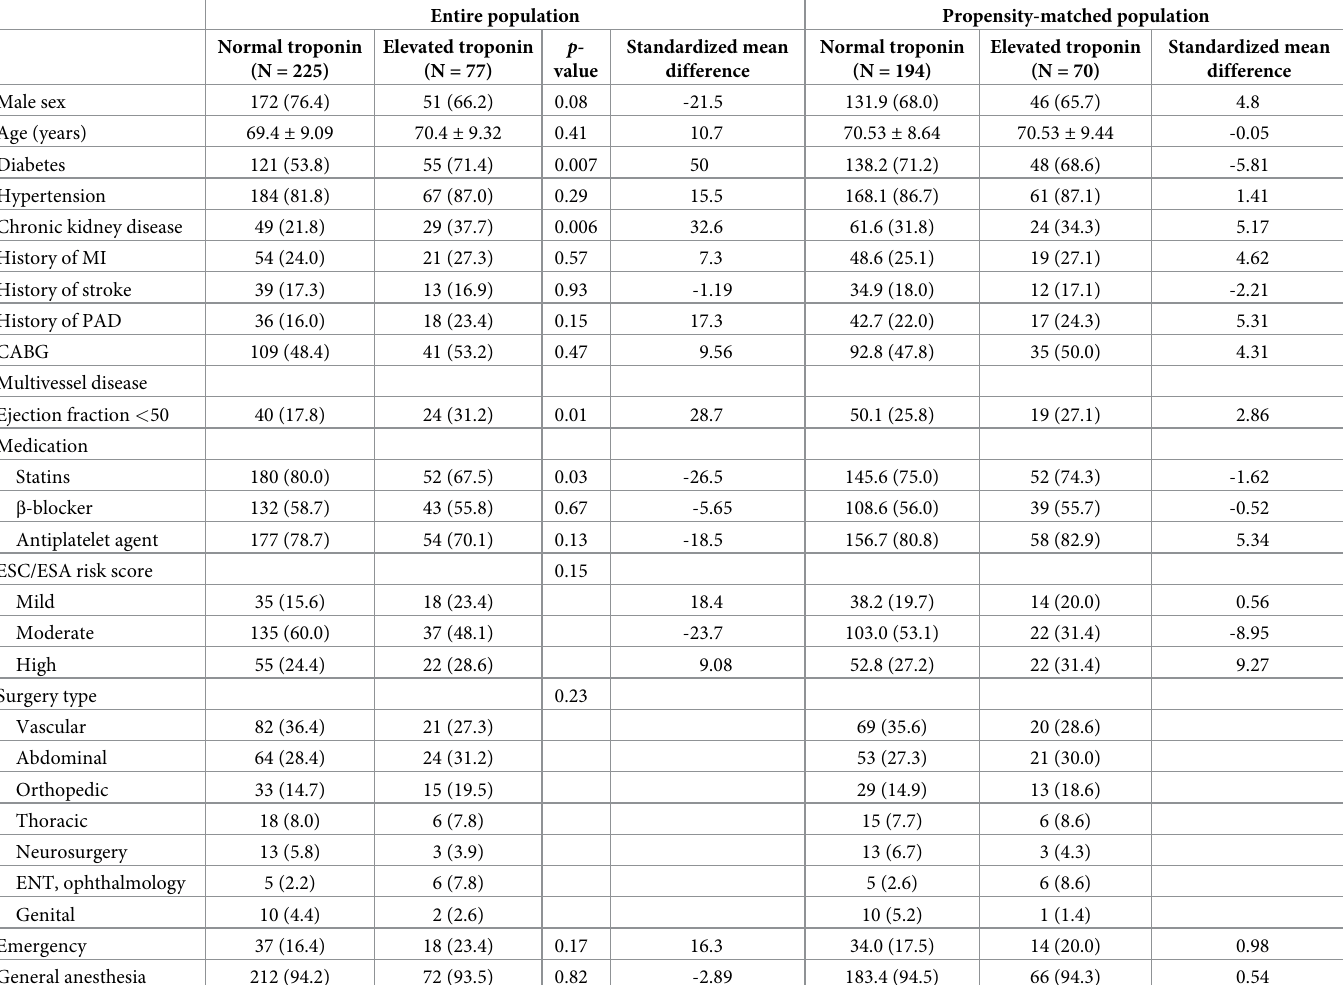
Table 3. Baseline characteristics of the preoperative